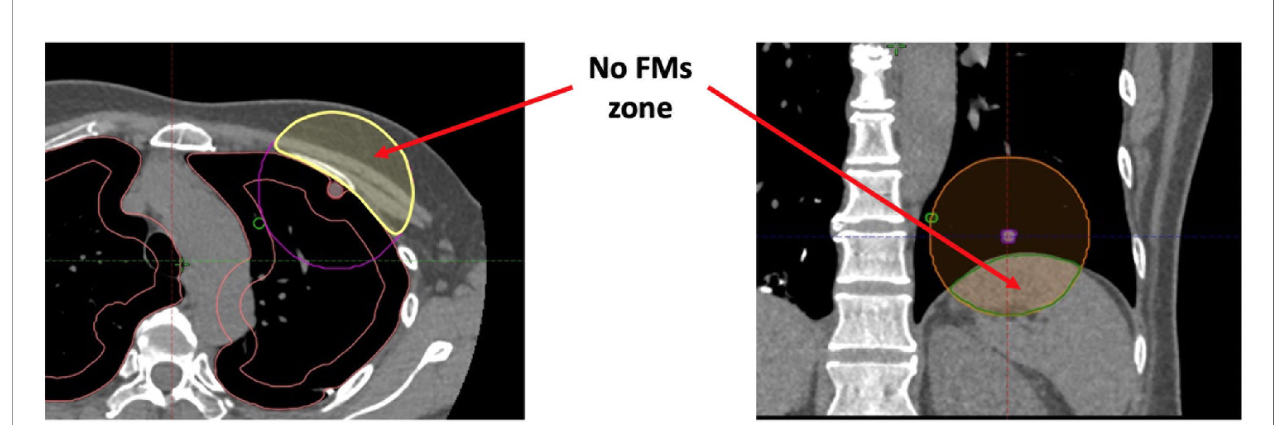
FIGURE 10 | The illustration of no-FM zone if the lung tumour is close to the